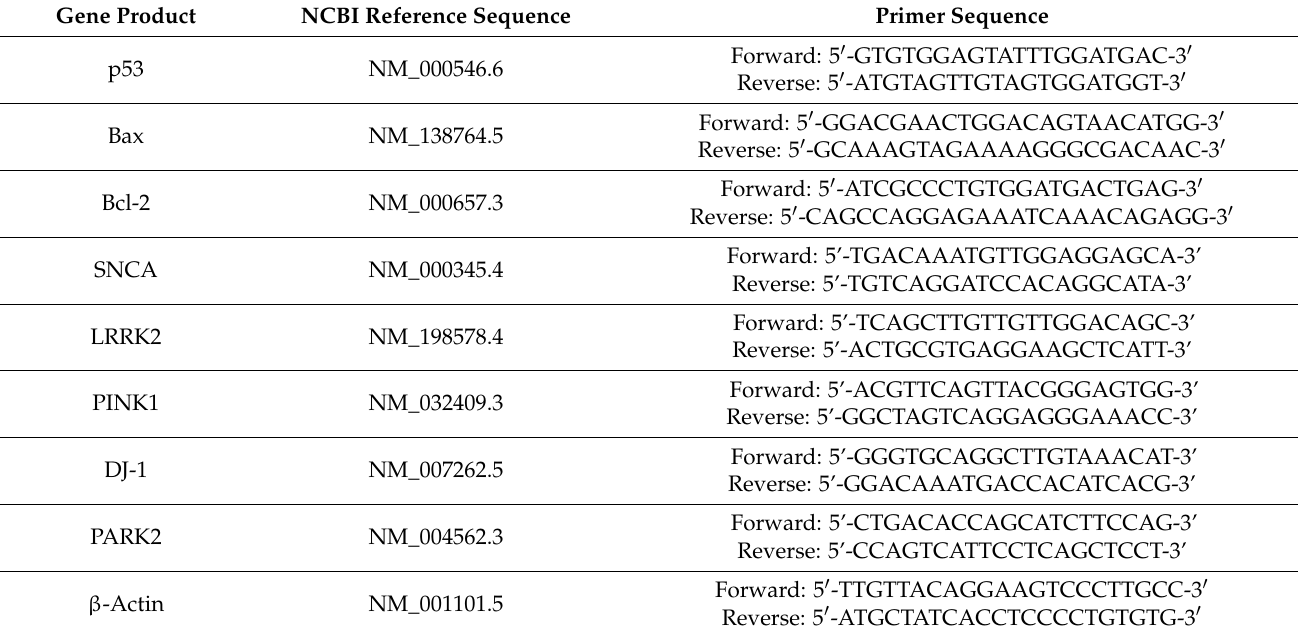
Table 1. Oligonucleotide primers used for real-time